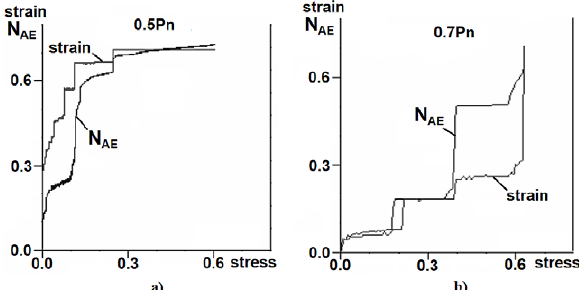
Figure 7. The results of acoustic tests for load of 0.5 Pn (a)